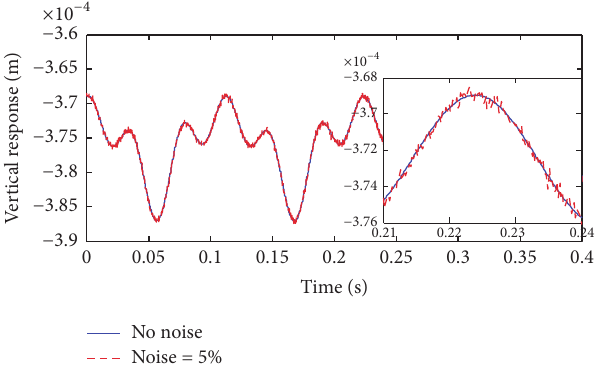
Figure 6: Typical response of the double-cracked rotor in steady